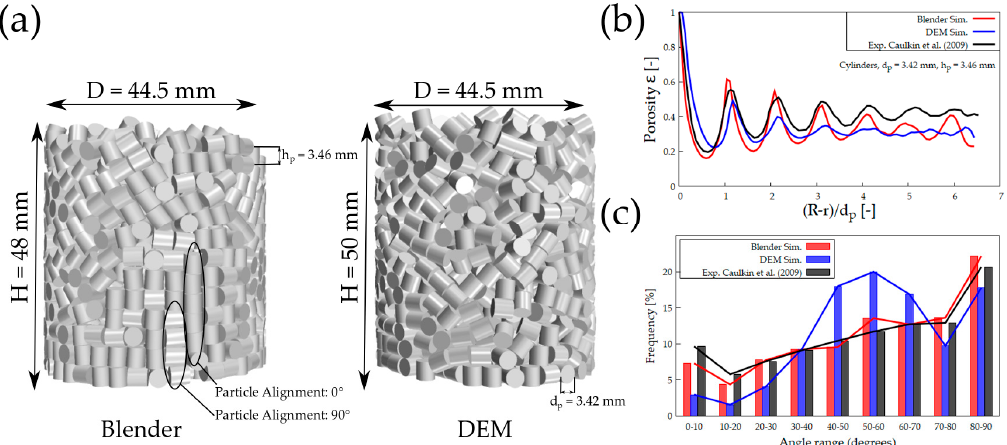
Figure 8. ( a ) Comparison between synthetic generated packing of cylinders, ( b ) radial density distribution, and ( c ) particle alignment. Experiments from Caulkin et al. [15].